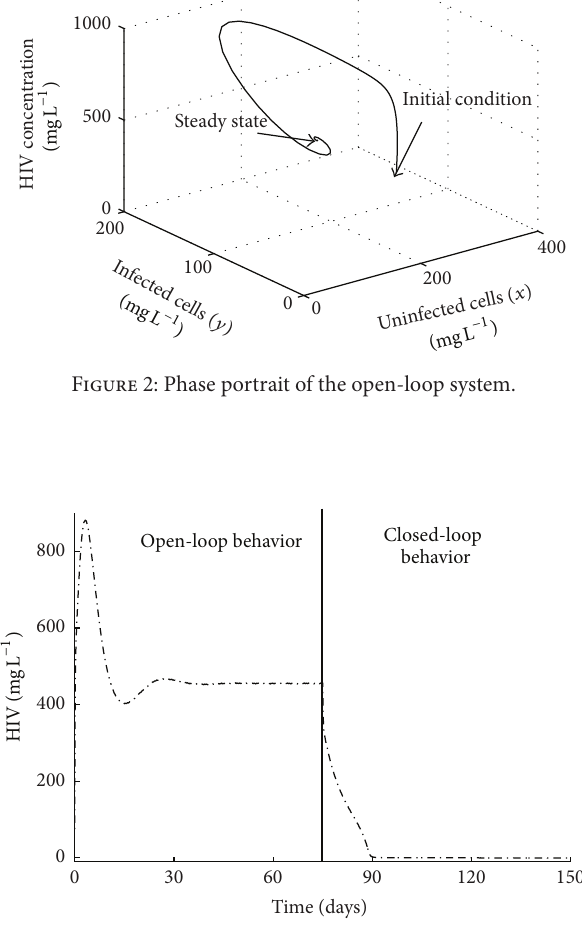
Figure 3: Closed-loop dynamics of the HIV concentration.